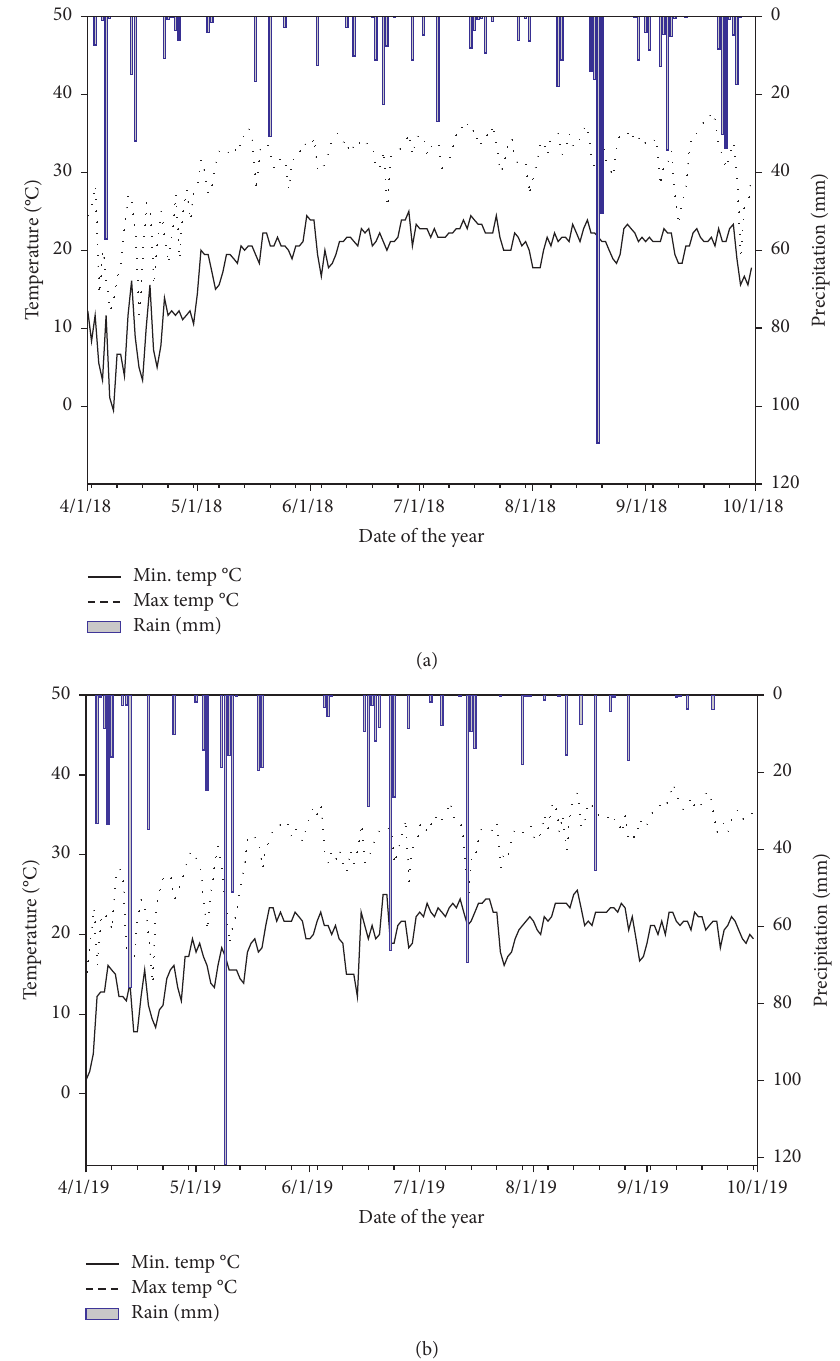
Figure 1: Measured air temperature and precipitation in 2018 and 2019 soybean growing seasons at Stoneville, MS, USA. (a) 2018 and (b)